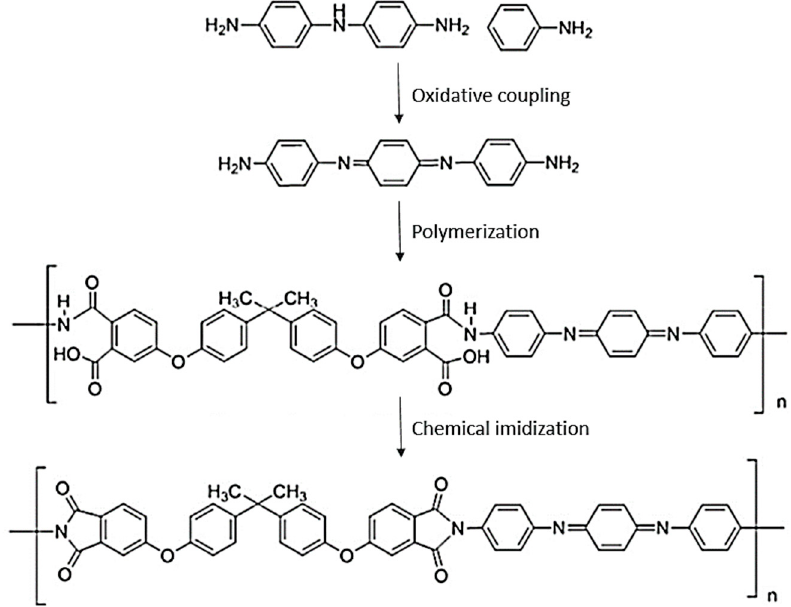
Scheme 1. Proposed mechanism for the synthesis of electroactive polyimide.